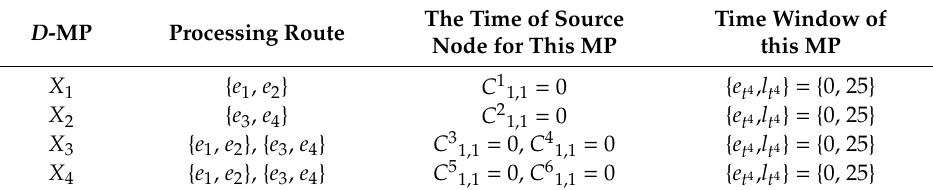
Table 11. The results of Step 3.